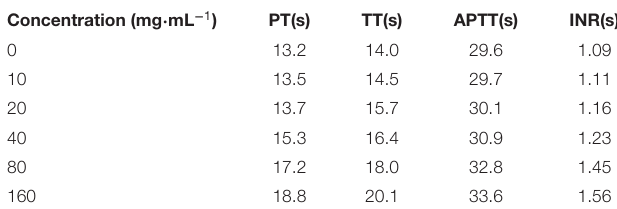
TABLE 2 | Effects of PLA combined Fe 3 O 4 -GO-ASA nanobubbles with the different concentrations on the coagulation blood parameters.